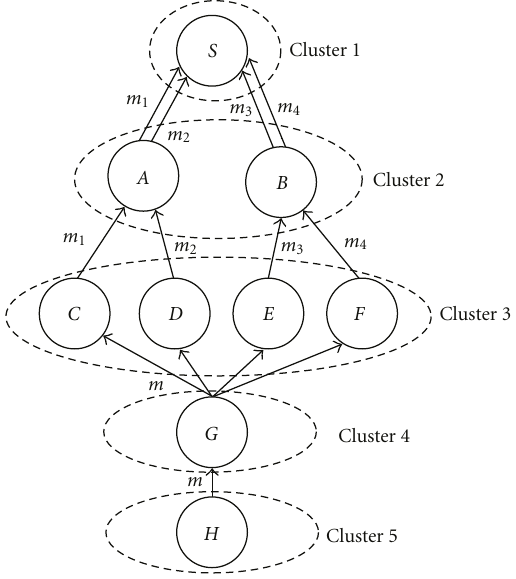
Figure 5: Forwarding